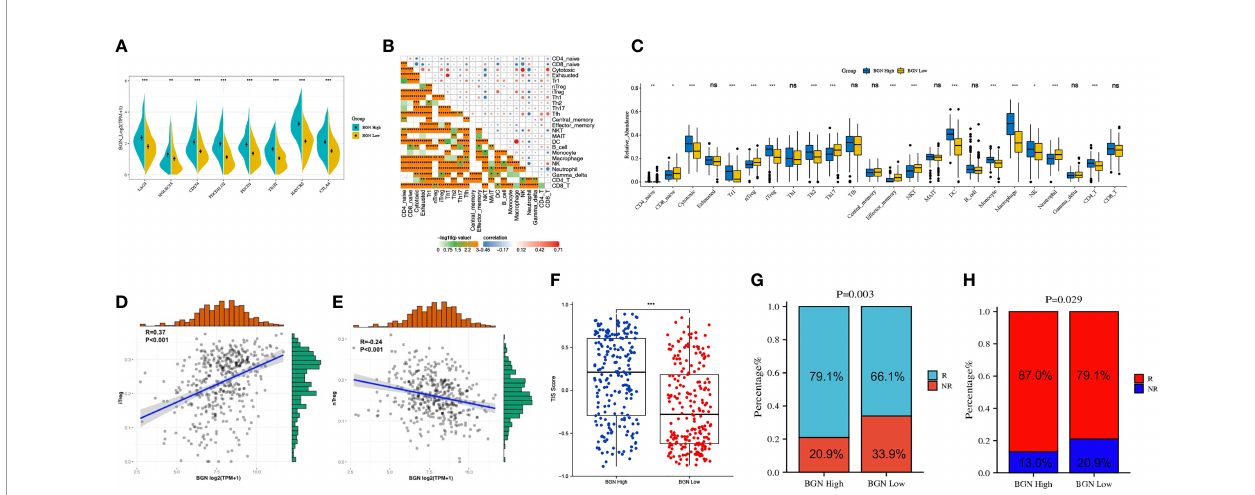
FIGURE 7 | Subgroups divided by levels of BGN expression predict potential immunotherapy responses of colon cancer. (A) Immune-checkpoint-relevant genes expressed in high and low BGN subgroups. Wilcoxon rank sum test served as the statistical signi fi cance test. (B) Pearson correlation matrix of the different TIIC proportions in the colon cancer microenvironment quanti fi ed by the ImmunCellAI. (C) The fraction of TILCs in BGN high and low subgroups. Wilcoxon rank sum test served as the statistical signi fi cance test. (D, E) The correlation between the abundance of (D) iTreg cells or (E) nTreg cells and the expression level of BGN. (F) T- cell in fl ammatory signature (TIS) scores across BGN subgroups. (Wilcoxon rank sum test, p < 0.001) (G, H) Response rates to immunotherapy of patients with colon cancer from the TCGA cohort predicted by the (G) ImmunCellAI (Chi-square test, p = 0.003) and (H) Tumor Immune Dysfunction and Exclusion (TIDE) web program (Chi-square test, p = 0.029) in the high or low BGN subgroups. *p < 0.05; **p < 0.01; ***p < 0.001; ns: p > 0.05 no signi fi